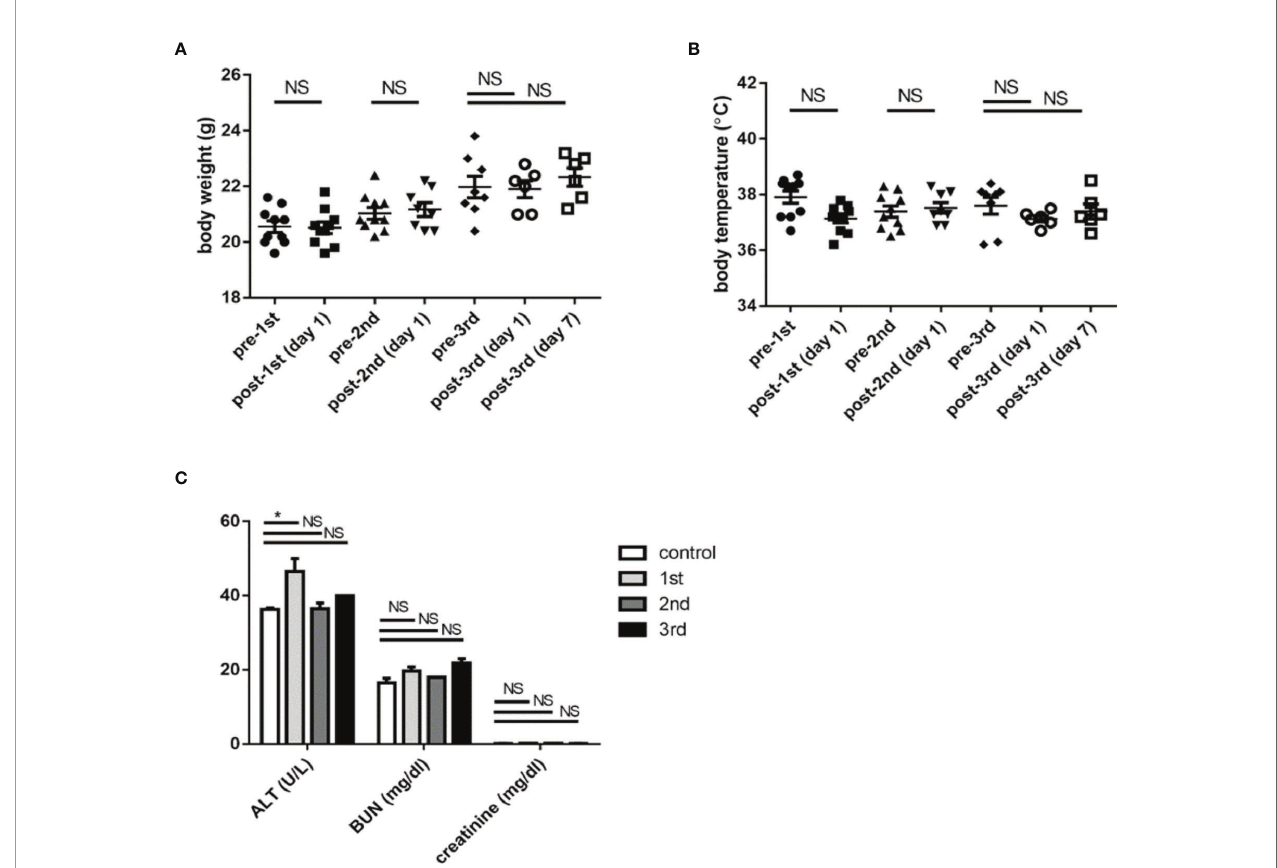
FIGURE 3 | The safety of K1 CPS-conjugated vaccine. (A) The body weights of mice were recorded before and one day after each administration (1st, 2nd, and 3rd) of K1 CPS-conjugated vaccine. (B) The rectal temperatures of mice were recorded before and one day after each administration of K1 CPS conjugated vaccine. (C) Blood levels of markers of liver (ALT) and renal (BUN and creatinine) functions were determined one week after each administration of K1 CPS-conjugated vaccine. Note: body weight and temperature data of individual animals were plotted in panels A and B; the horizontal bar indicates the mean, and the error bar indicates SEM. For (C) , blood level values are plotted as mean + SEM. The data were analyzed using the Tukey ’ s multiple comparison post hoc one-way ANOVA analysis. * P < 0.05; NS, not signi fi cant. Although ALT levels are slightly higher 1 week after vaccination. *ALT titers are all within normal range. Similar observations were noted in K2 vaccinated mic but serum biochemical tests were not